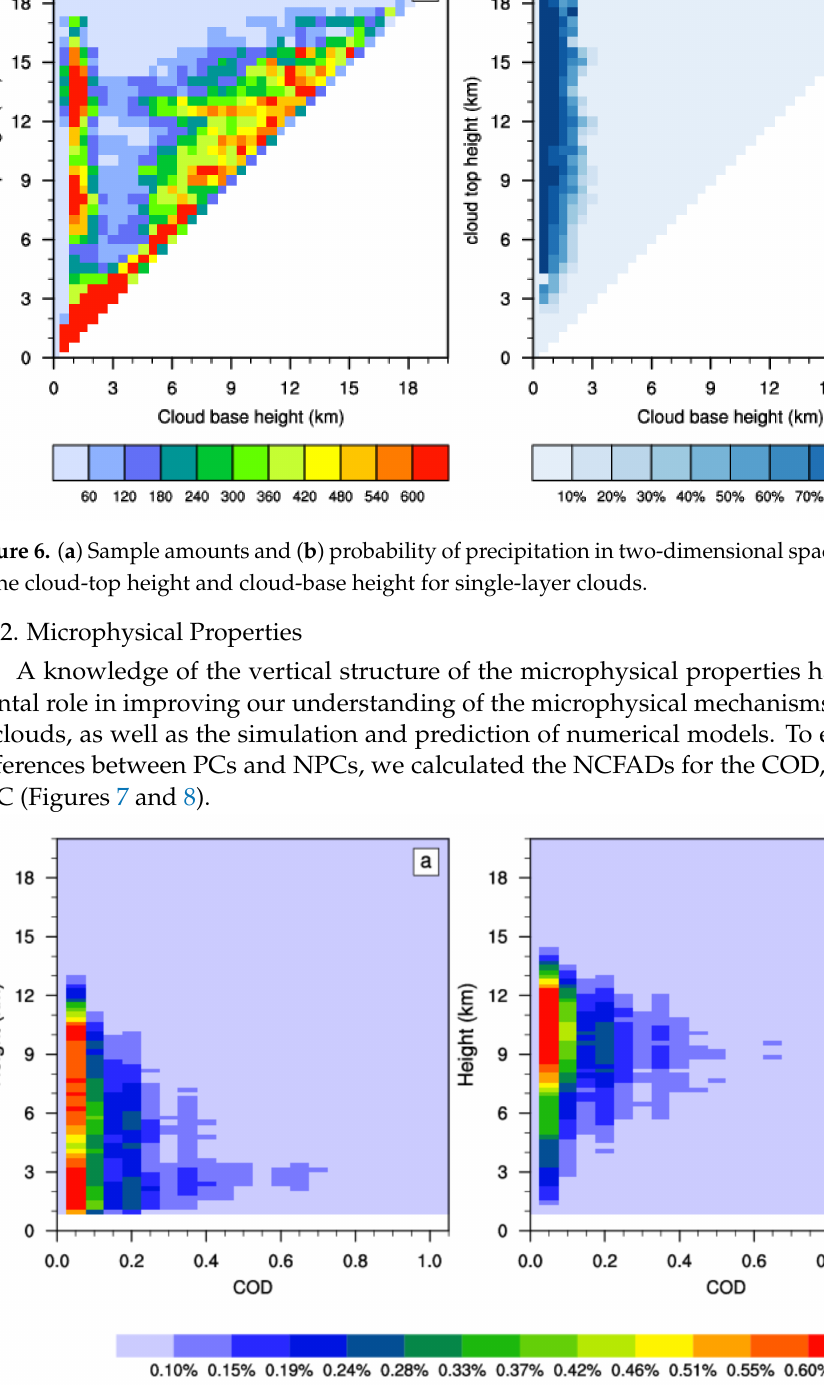
Figure 7. Normalized contoured frequency by altitude diagrams for the cloud optical depth of ( a ) precipitating clouds and ( b ) non-precipitating